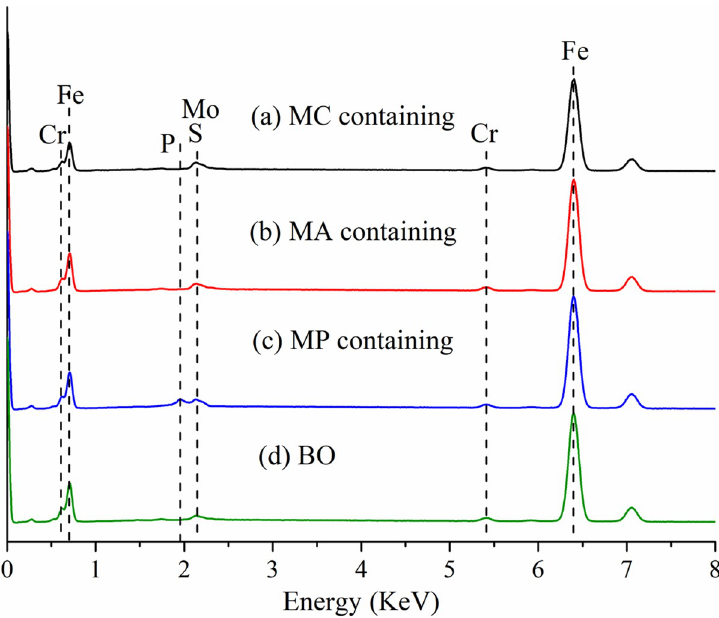
Fig 11. EDS of friction surfaces (a) MoDTC (MC) containing lubricants, (b) molybdenum amide (MA) containing lubricants, (c) MoDDP (MP) containing lubricants, (d) Base oil (BO).